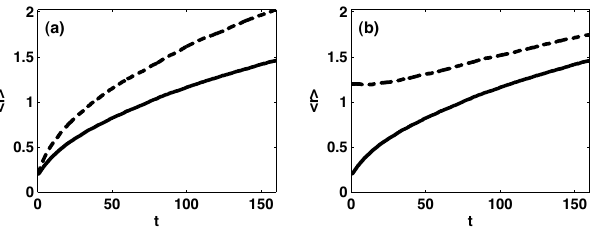
Fig. 2. Mean radius as a function of time for stochastically perturbed pathlines in an irrotational vortex. (a) the effect of doubling the correlation time, solid line – control case, dashed line – double the correlation time, (b) the effect of initial position, solid line – control case, dashed line – initial radius increased by one dimen- sionless